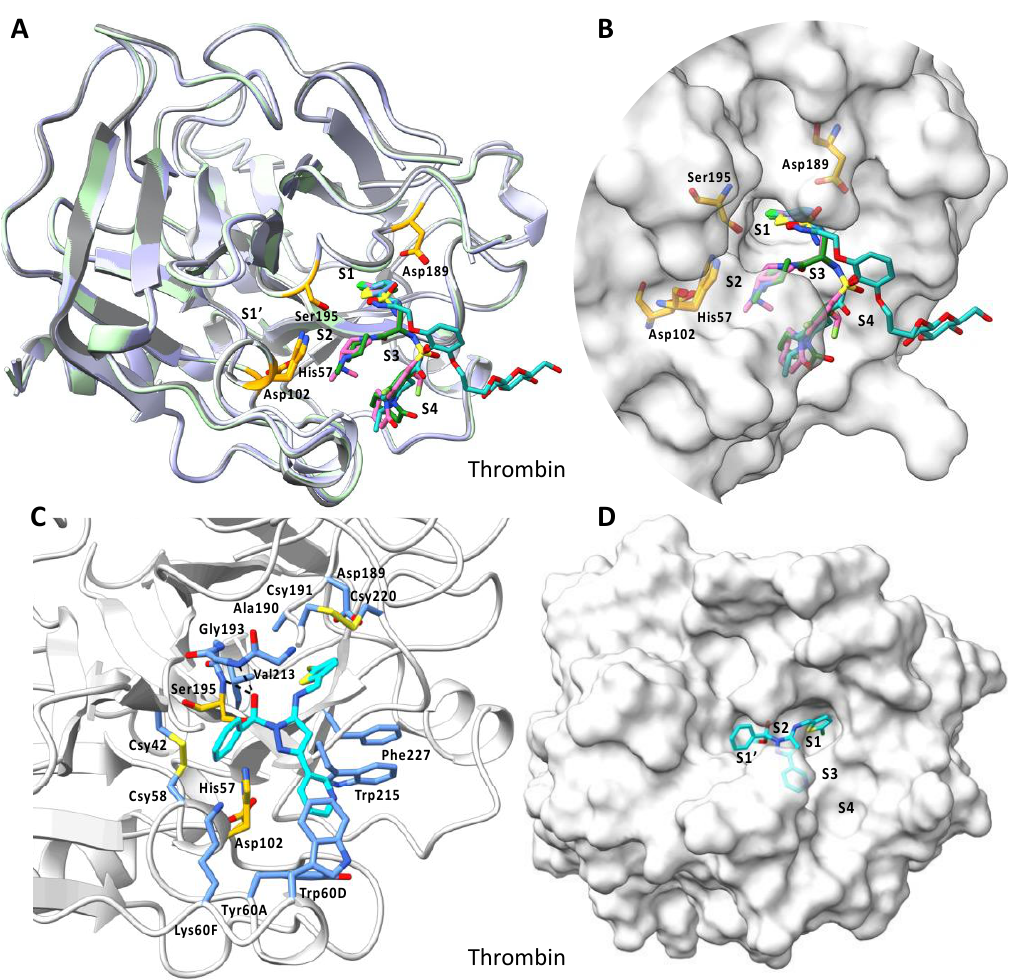
Figure 6. Four superimposed thrombin X-ray crystal structures ( A — ribbons, B — molecular surface) with bound inhibitors exhibiting the 5-chlorothiophenyl moiety (PDB ID: 4LOY [32] , 4LXB [32] , 6EO8 [33] , and 6YQV). In all superimposed structures, the inhibitors’ 5 -chlorothiophenyl moiety resides in the S1 pocket. Calculated covalent binding conformation of inhibitor 25 (cyan stick model) in the active site of thrombin ( C — close-up view and D — overall structure with molecular surface). Amino acid residues are depicted as orange or blue stick models and are numbered according to the amino acid sequence of chymotrypsinogen residue numbering. Oxygen, nitrogen, and sulfur atoms are colored in red, blue, and yellow, respectively. Substrate-binding sites are labeled (S1 – S4 and S 1′ ). Hydrogen bonds are black lines. PDB ID used for docking: 6CYM [16] .